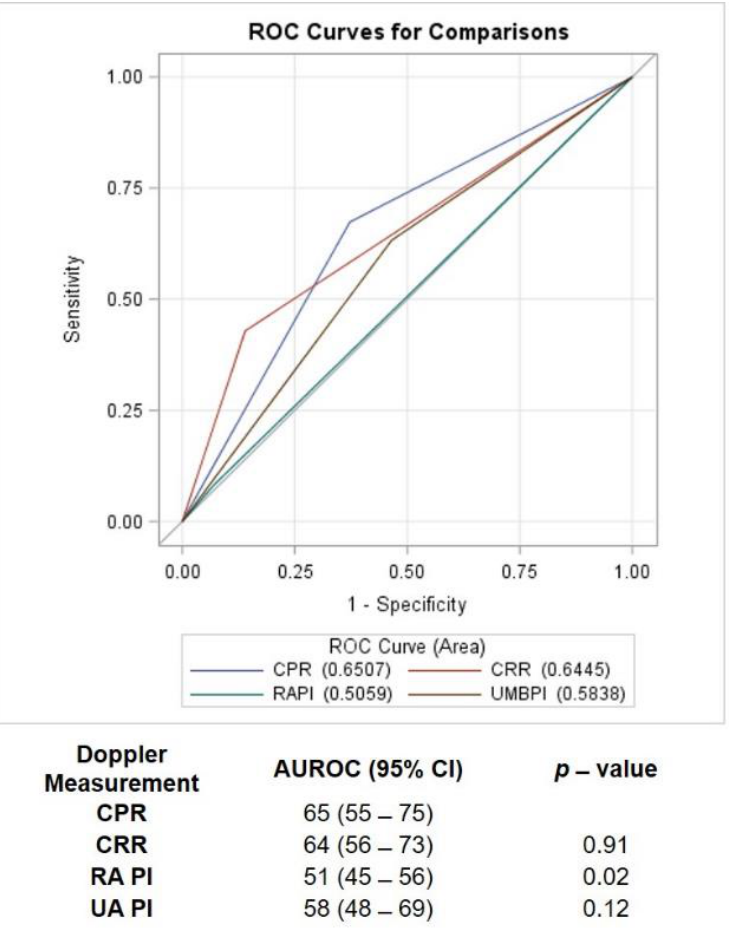
Figure 3. Comparison of the area under the receiver operating characteristics curve (AUROC) for each test to detect the composite neonatal outcome. ROC: receiver operating characteristics, PI: pul- satility index, CPR: cerebral–placental ratio, CRR: cerebral–renal ratio.